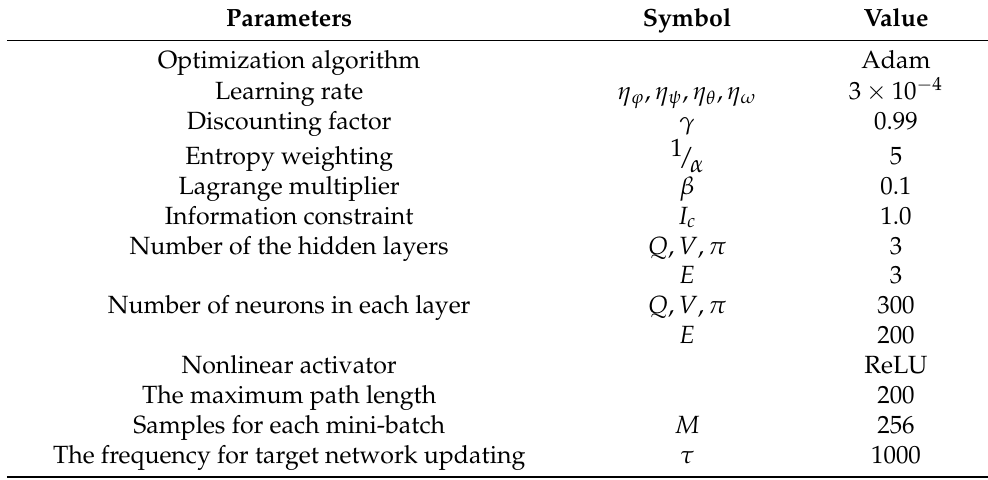
Table 2. Hyper parameters for the proposed meta reinforcement learning algorithm. Parameters Symbol Value Optimization algorithm